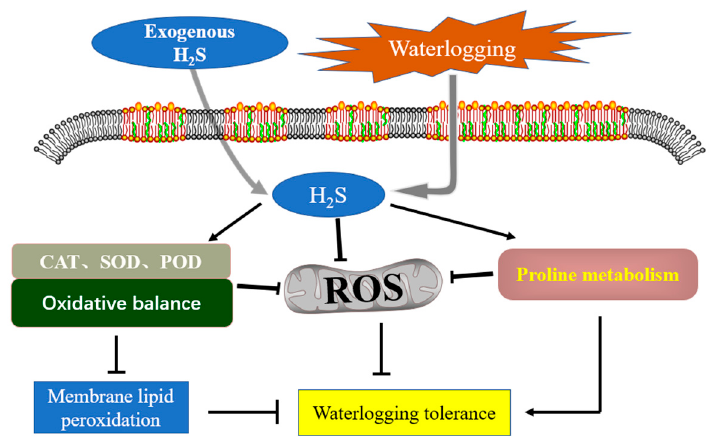
Figure 3. Schematic diagram of H 2 S enhancing the activity of antioxidant system to acquire the tol- erance to waterlogging-induced hypoxia. tolerance to waterlogging-induced